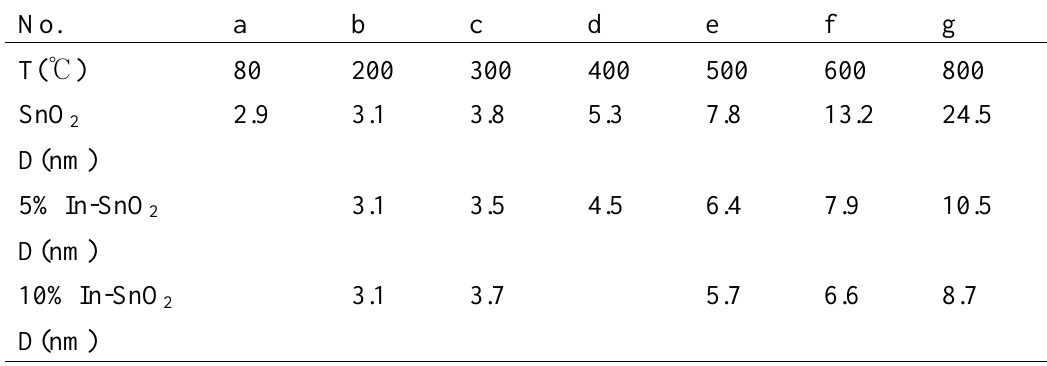
Table 1. The effect of the particle size of the sample with different doped quantities on the calcining